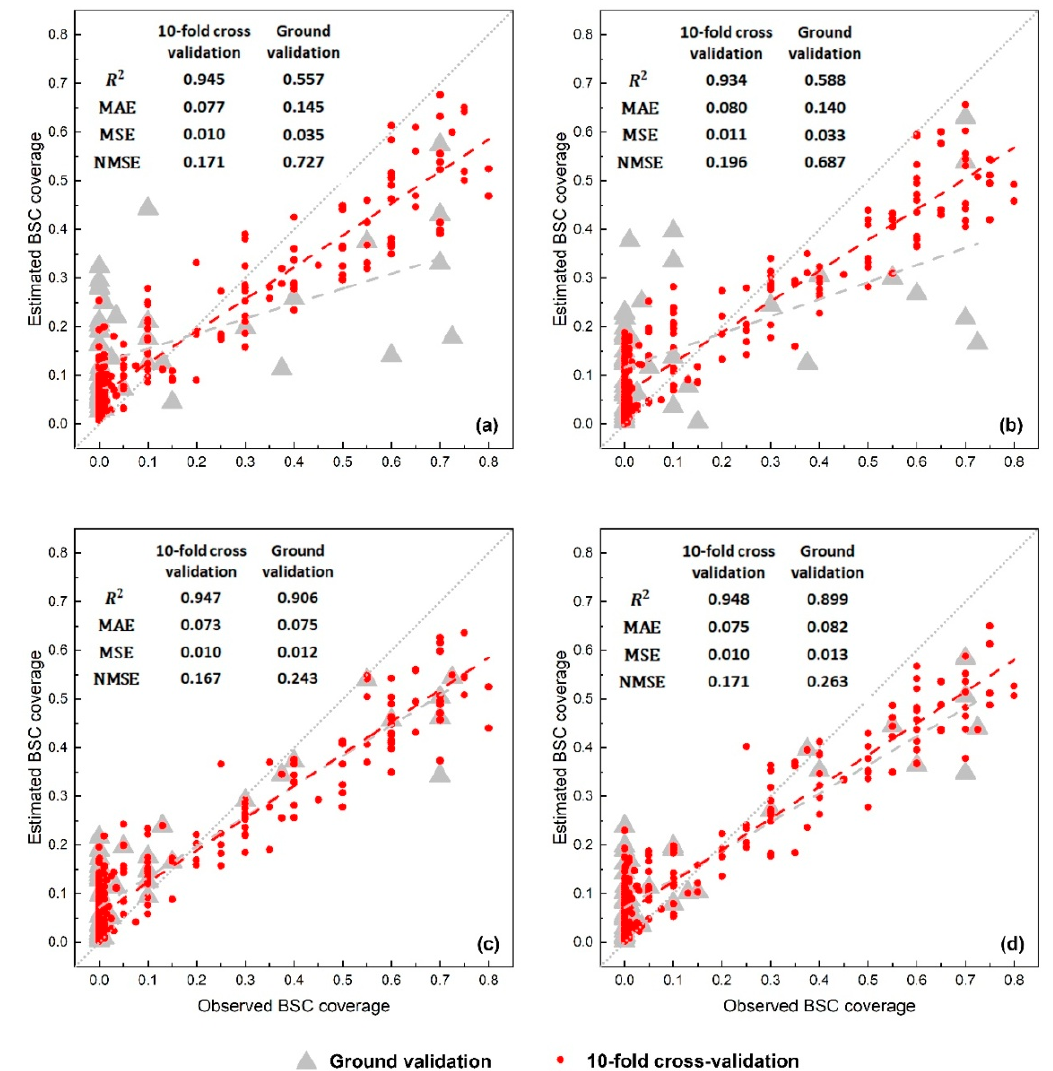
Figure 8. Plots of estimated coverage versus measured coverage of BSCs on a pixel scale by: ( a ) Landsat data with band combinations based on CI; ( b ) Landsat data with band combinations based on BSCI; ( c ) Sentinel data with band combinations based on CI; ( d ) Sentinel data with band combinations based on BSCI. Dot line plot function is y = x. Red dashed lines are linear fittings of 10-fold cross-validation; grey dashed lines are linear fittings of ground validation; red points represent results from 10-fold cross-validation of models; gray triangles represent results of ground validation.